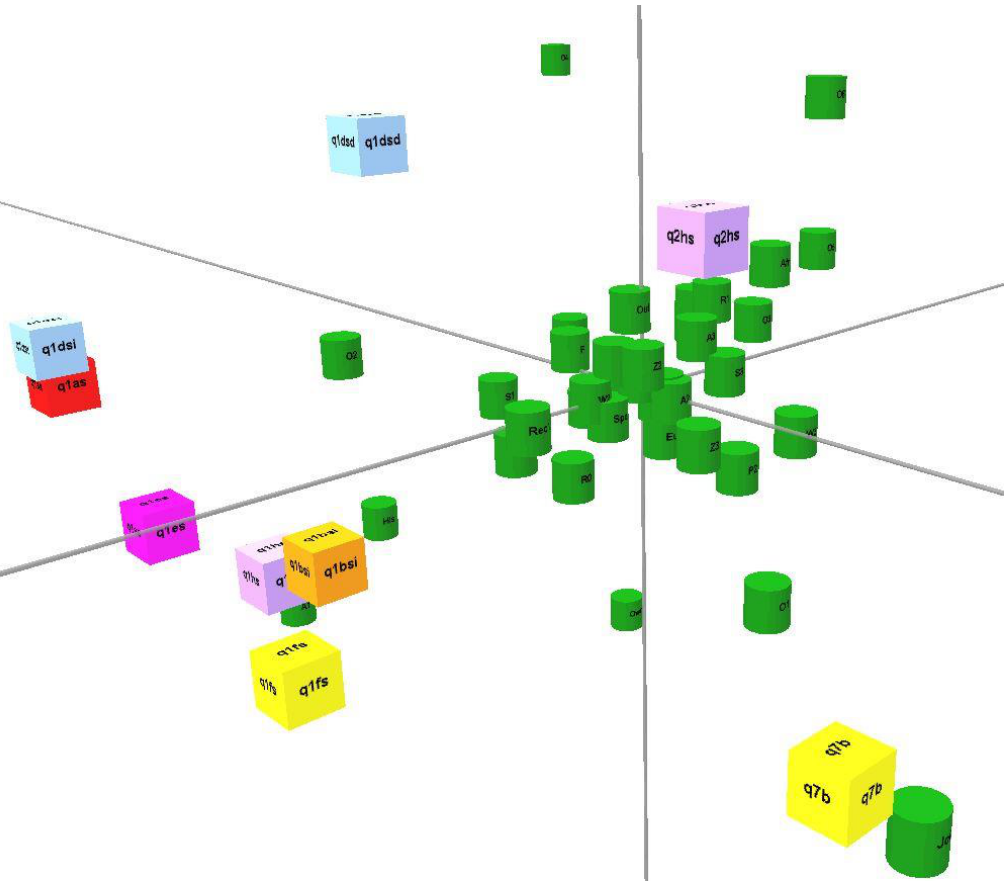
Figure 6. Main cluster of the individual variables with the categories referring to closest ailments (Please see: https://youtu.be/E_zsndLsO-U).